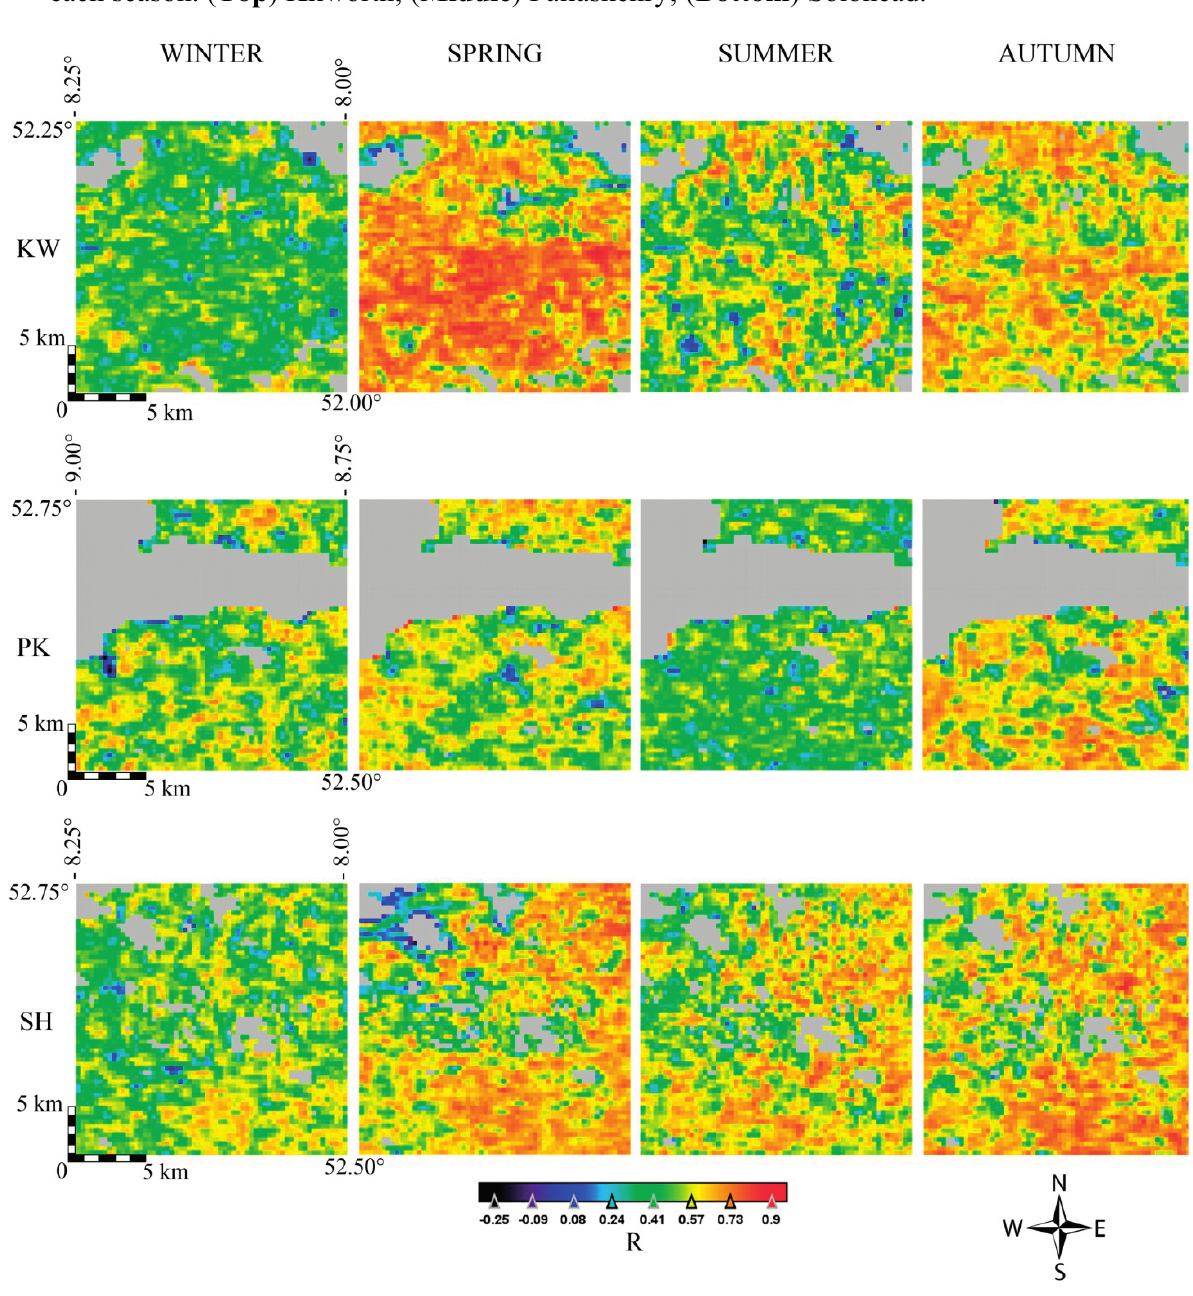
Figure 7. ASAR SM vs. ECV SM correlation maps evaluated for each ASAR pixel and